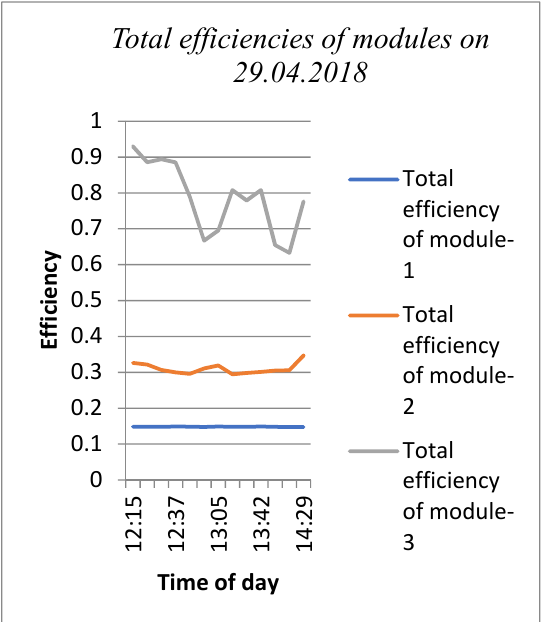
Figure 18. Totalefficiencies of modules on 29.04.2018.